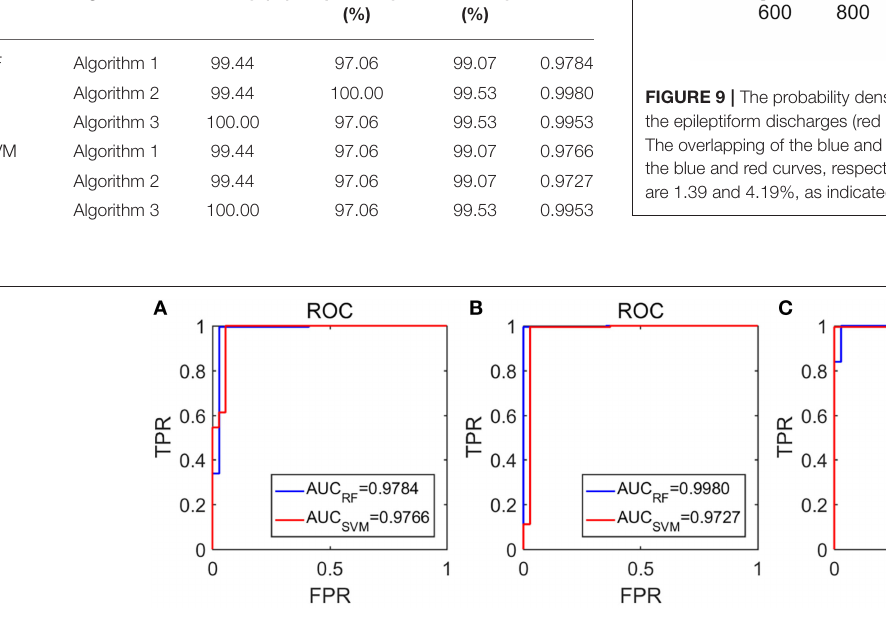
Frontiers in Bioengineering and Biotechnology |